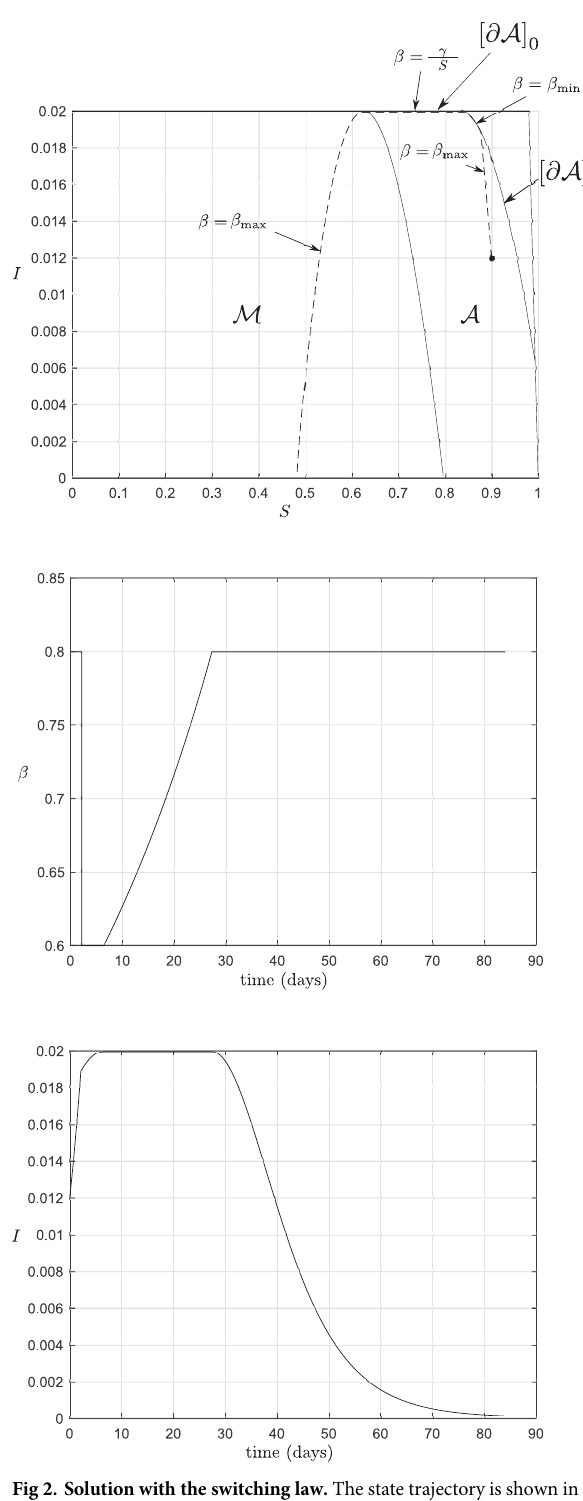
Fig 2. Solution with the switching law. The state trajectory is shown in the top figure (dashed curve). The middle plot is of the intervention strategy, β , and the right plot is the proportion of infectives over time.